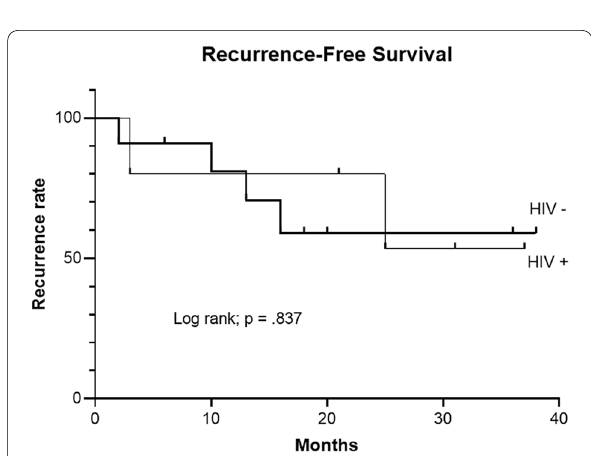
Fig. 2 Recurrence-free survival after liver resection in HIV-positive and HIV-negative